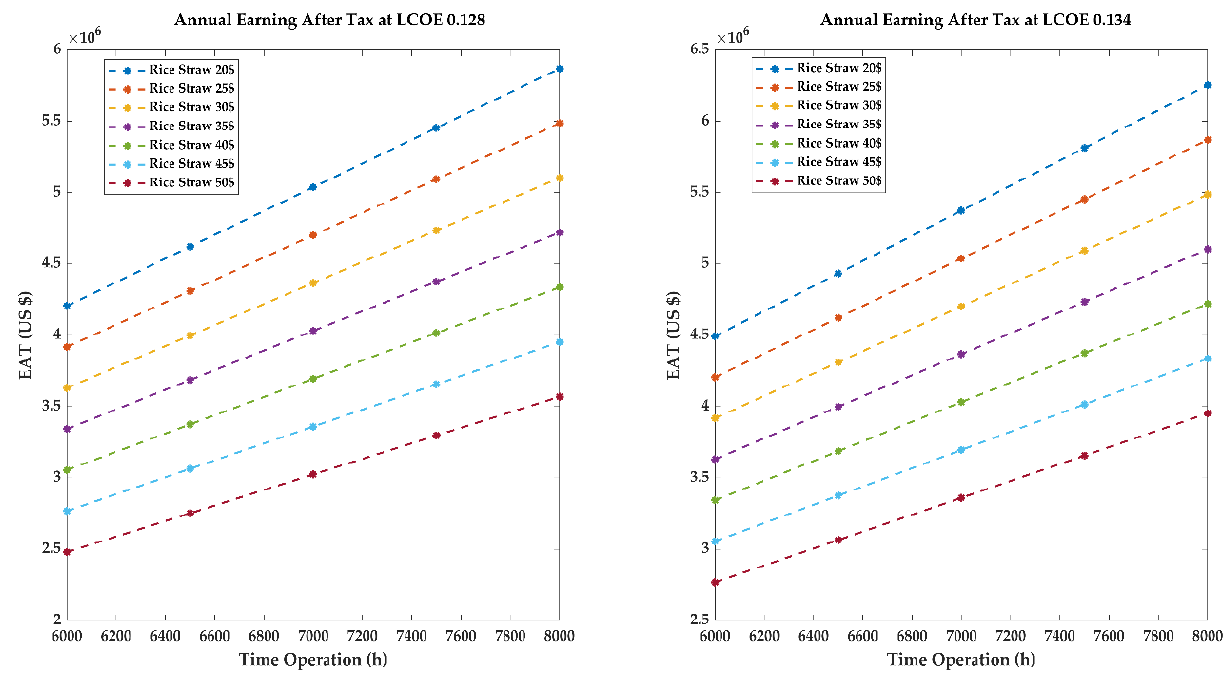
Figure 7. The annual earnings after tax payment. Table 10. The growth of EAT when adjusting 500 h of time operation.